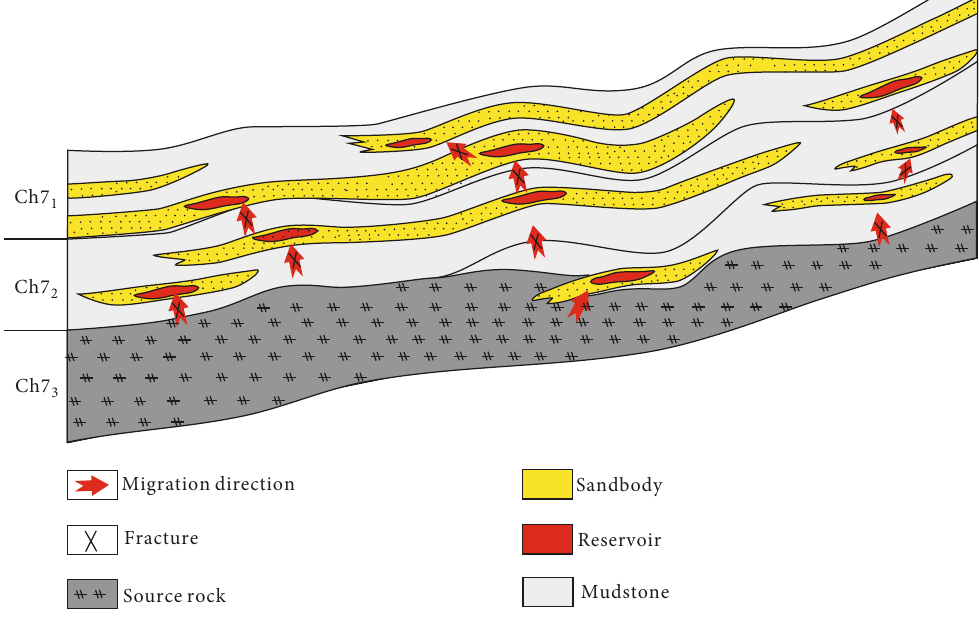
Figure 16: Reservoir forming model map of Chang 7 reservoir in southeast Ordos